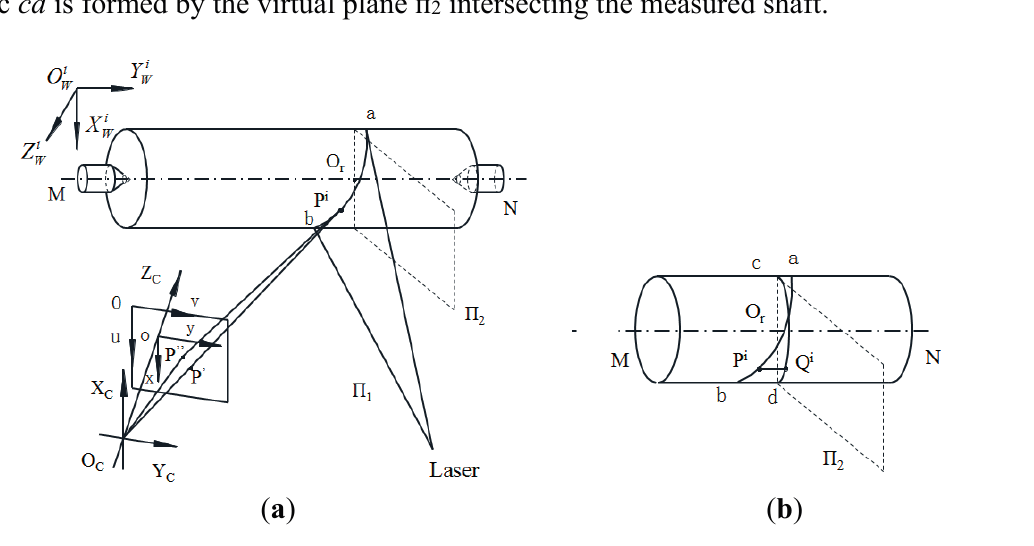
Figure 6. The measurement model of the shaft. ( a ) global view, ( b ) local